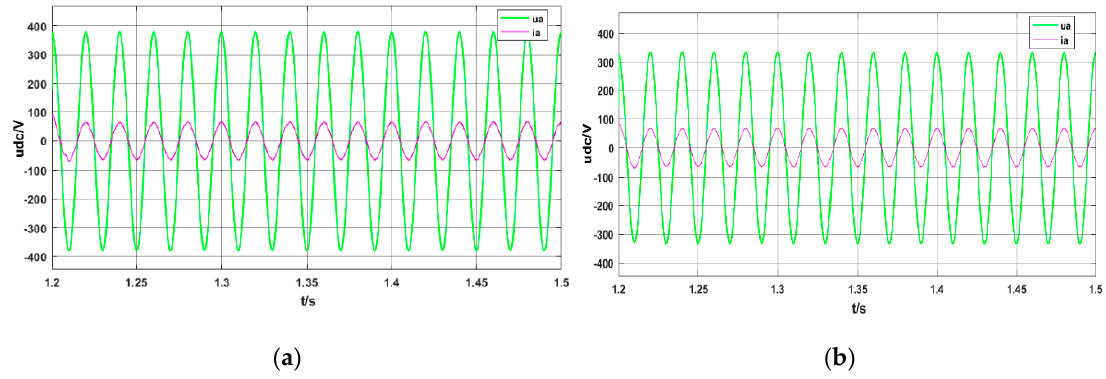
Figure 14. Grid voltage and current of phase A: ( a ) PI controller and ( b ) SMADRC controller.